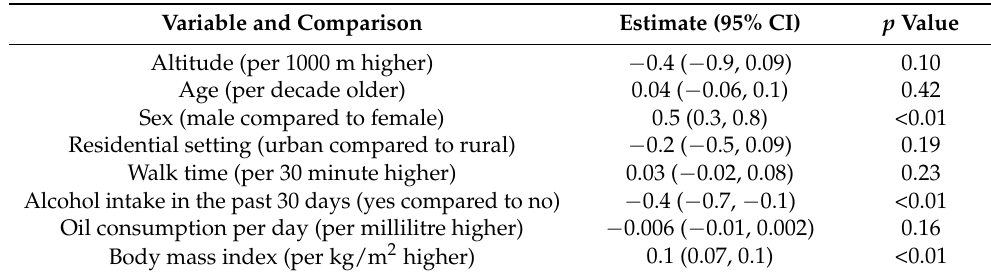
Table 3. Estimates of the mean TC to HDL ratio for altitude in a multivariate analysis of covariance (ANCOVA) and associations for confounding variables.